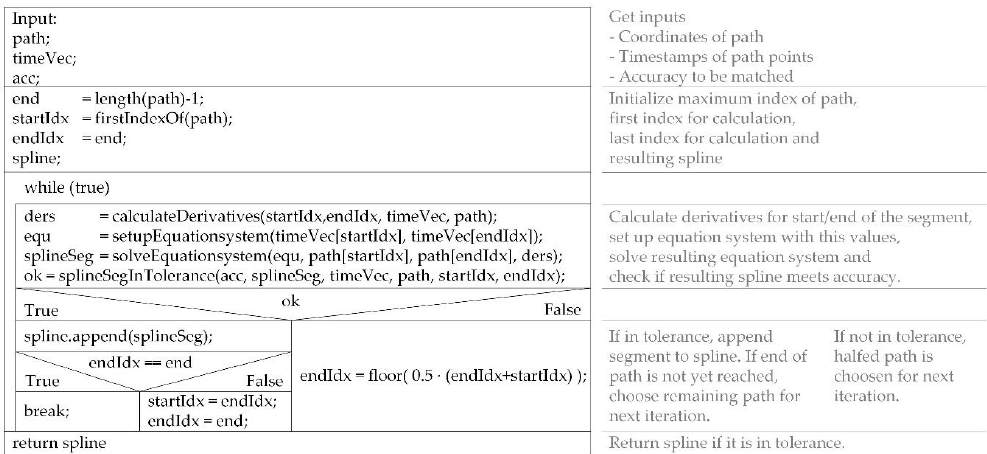
Figure 5. Monomial spline-based iterative algorithm msITER.